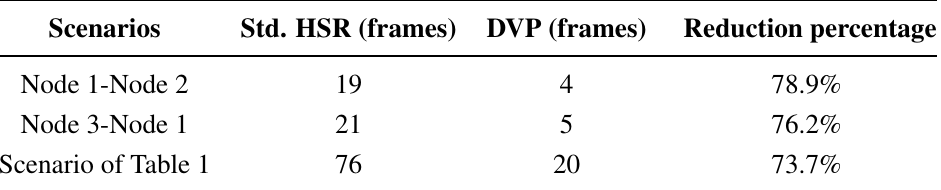
Table 3. Network traffic comparison between the standard HSR protocol and DVP algorithm under the link-failure